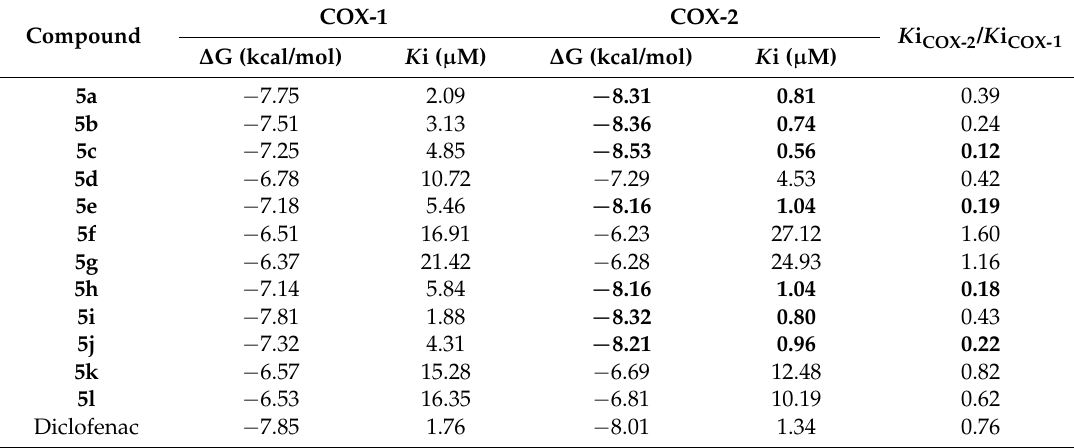
Table 4. The selectivity of the tested compounds ( 5a – l ) to the COX 1 and COX 2 enzymes expressed as variation of the Gibbs free energy ( ∆ G) and the consequent predicted inhibition constant ( K i). Compound